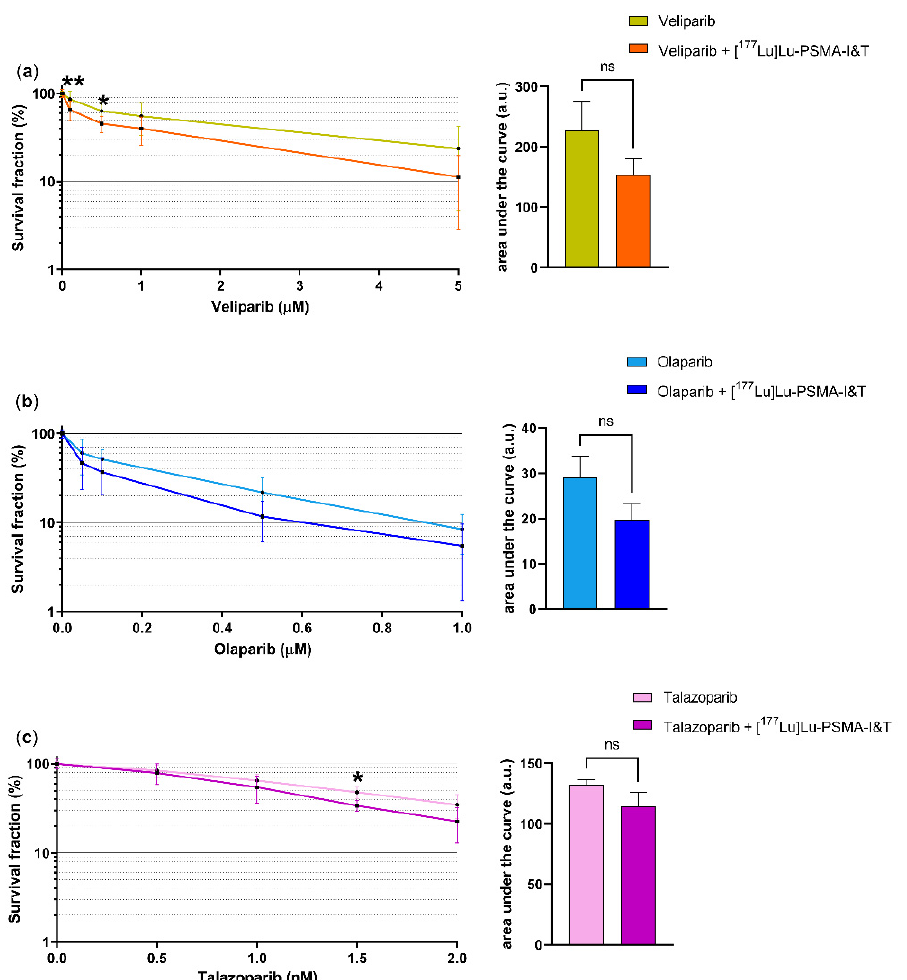
Figure 1. Quantification of the clonogenic survival of PC3-PIP cells treated with [ 177 Lu]Lu-PSMA- I&T in combination with increasing concentrations of veliparib ( a ), olaparib ( b ) and talazoparib ( c ) compared to PARPi monotherapy and the corresponding area under the curve comparison. No PARPi conditions were used to normalize for both [ 177 Lu]Lu-PSMA-I&T and the mock-treated curves. Error bars represent standard error of the mean (SEM). Asterisks indicate significance compared to PARPi monotherapy (* p ≤ 0.05, ** p ≤ 0.01).